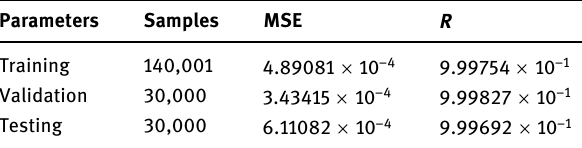
Table 4: Result samples of the proposed controller